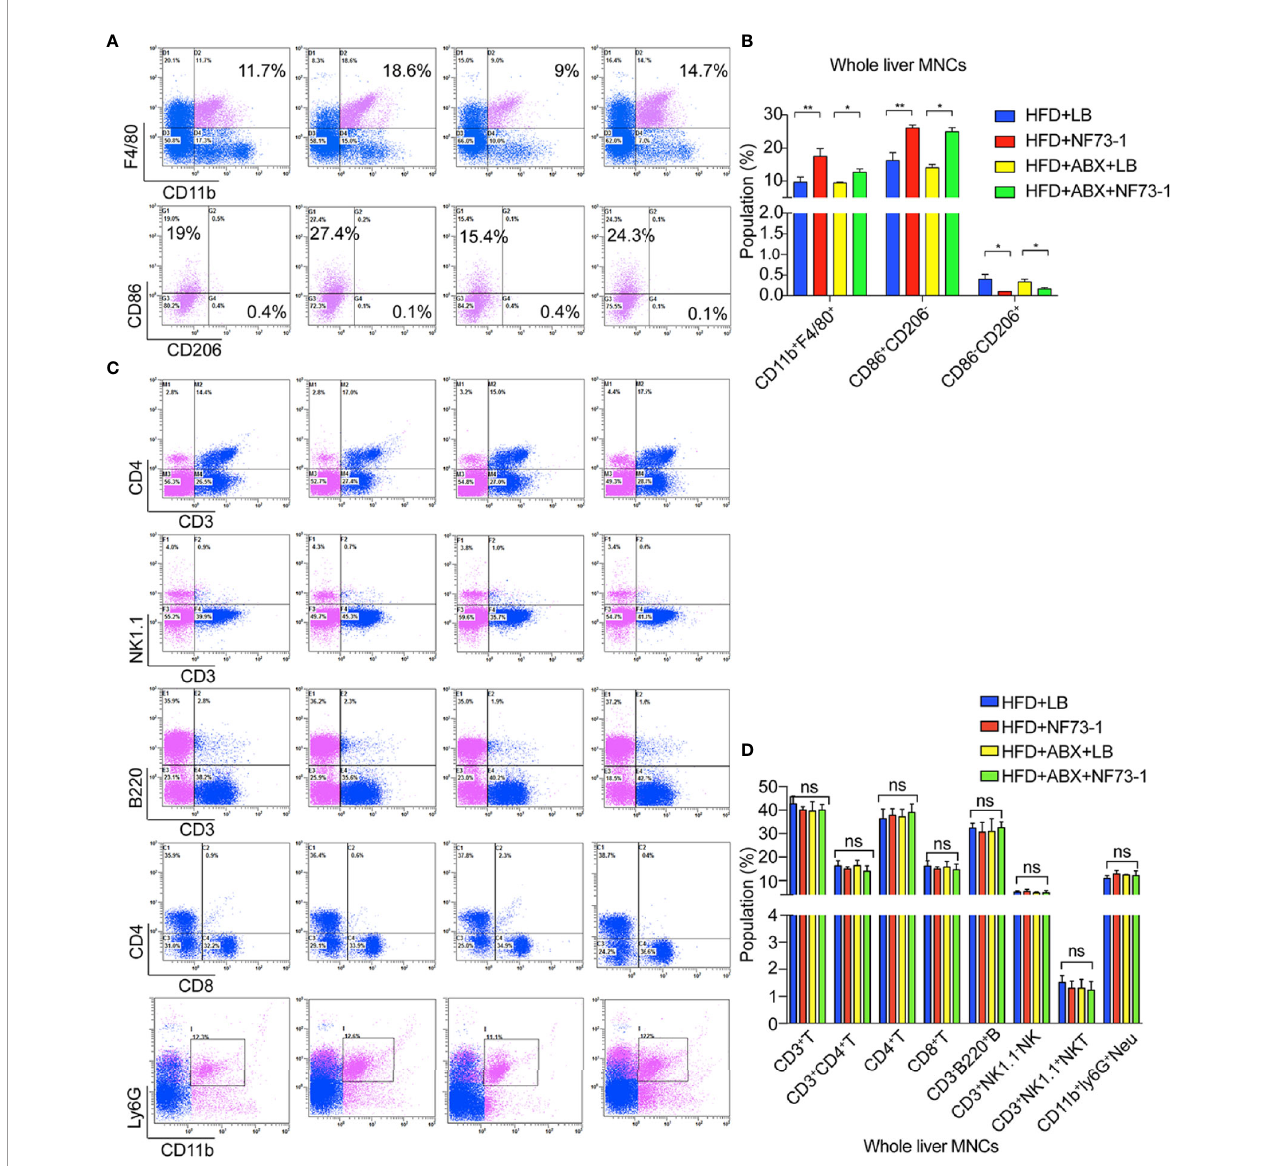
FIGURE 4 | M1 macrophage polarization in NAFLD mice with E. coli EGFP-NF73-1. (A) Representative fl ow cytometric plots of the CD45 + F4/80 + CD11b + liver macrophage population, M1(CD45 + F4/80 + CD11b + CD206 - CD86 + ) and M2(CD45 + F4/80 + CD11b + CD86 - CD206 + ) in the livers of the HFD-NF73-1, HFD-LB, HFD- ABX-NF73-1, and HFD-ABX-LB groups; (B) Liver macrophage counts in the livers of the HFD-NF73-1, HFD-LB, HFD-ABX-NF73-1, and HFD-ABX-LB groups; (C) Representative fl ow cytometric plots of the liver lymphocyte and neutrophil populations in the livers of the HFD-NF73-1, HFD-LB, HFD-ABX-NF73-1, and HFD-ABX-LB groups; (D) Lymphocyte and neutrophil counts in the livers of the HFD-NF73-1, HFD-LB, HFD-ABX-NF73-1, and HFD-ABX-LB groups. Data are calculated as the mean ± SEM, n = 4 – 6 per group. ns p>0.05, *p <0.05, **p <0.01 (unpaired t test). NAFLD, non-alcoholic fatty liver disease; HFD, high-fat diet.; NS, no signi fi